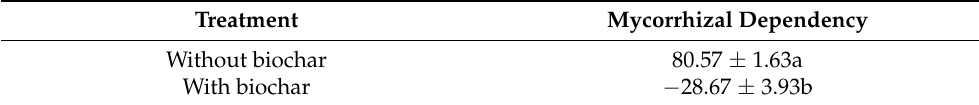
Figure 1. Effects of arbuscular mycorrhizal fungi and biochar on maize ( a ) shoot biomass, ( b ) root biomass, ( c ) total biomass, and ( d ) root–shoot ratio. Data are means of five replicates ± SEs. Different letters above the columns indicate significant differences according to Duncan’s test at p < 0.05. CK, control; A, arbuscular mycorrhizal fungi; B, biochar; AB, arbuscular mycorrhizal fungi and biochar. Table 4. Mycorrhizal dependency of inoculated maize following different biochar